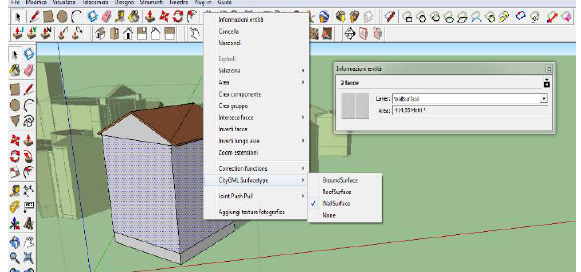
Figure 2. Converting SketchUp surface model into CityGML WallSurface feature type